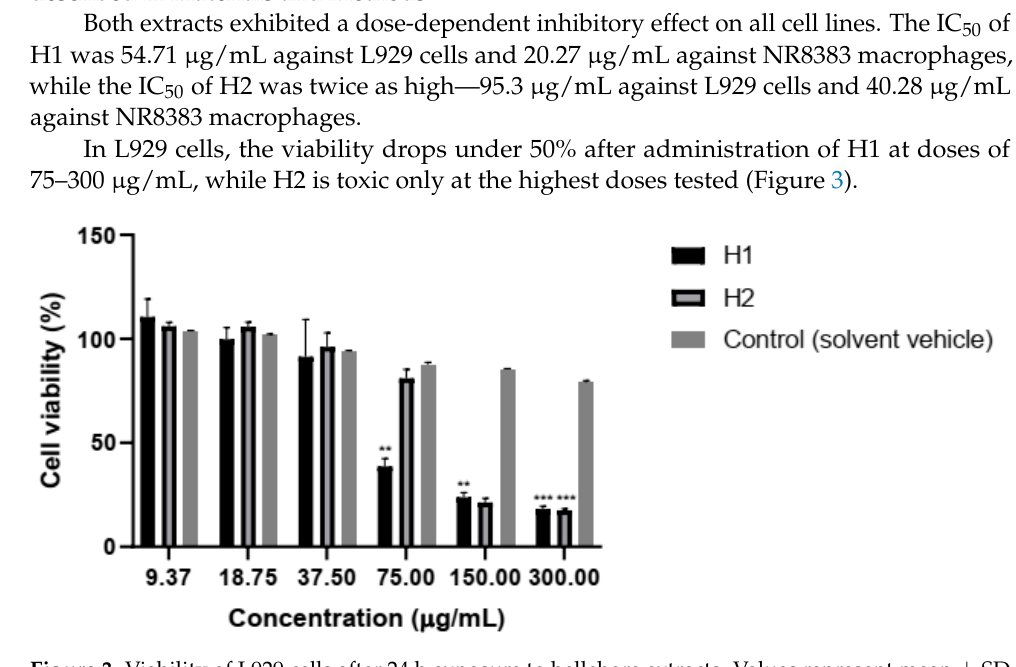
Figure 3. Viability of L929 cells after 24 h exposure to hellebore extracts. Values represent mean ± SD (n = 3, ** p < 0.01, *** p < 0.001).